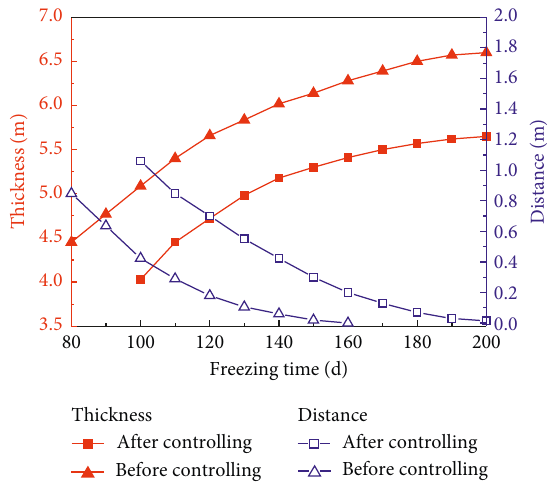
Figure 10: Comparison of the development of the frozen wall before and after adopting the local differential freezing technique.